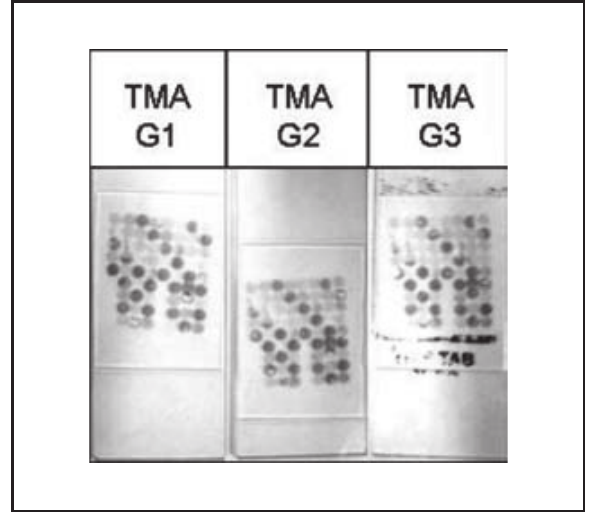
Figura 1 – Lâminas do grupo 1 (com silanização tradicional: TMA G1), grupo 2 (silanização modificada: TMA G2) e grupo 3 (lâminas com fita adesiva comercial: TMA G3)